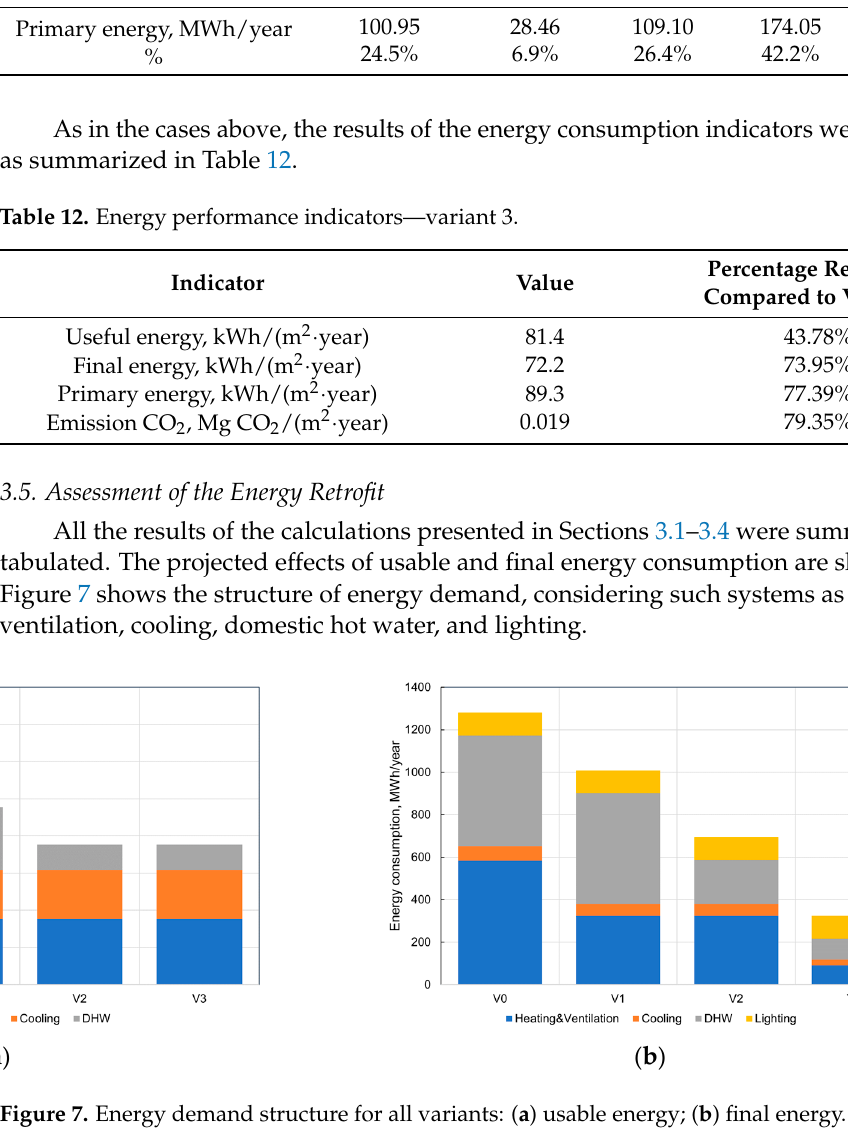
Table 11. Heat demand calculations after all retrofit activities—variant 3.